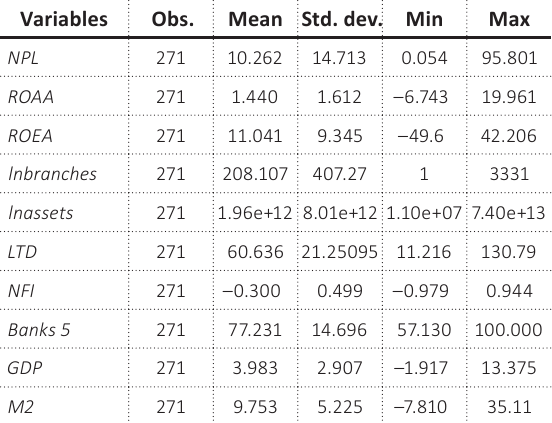
Table 2. Descriptive statistics of